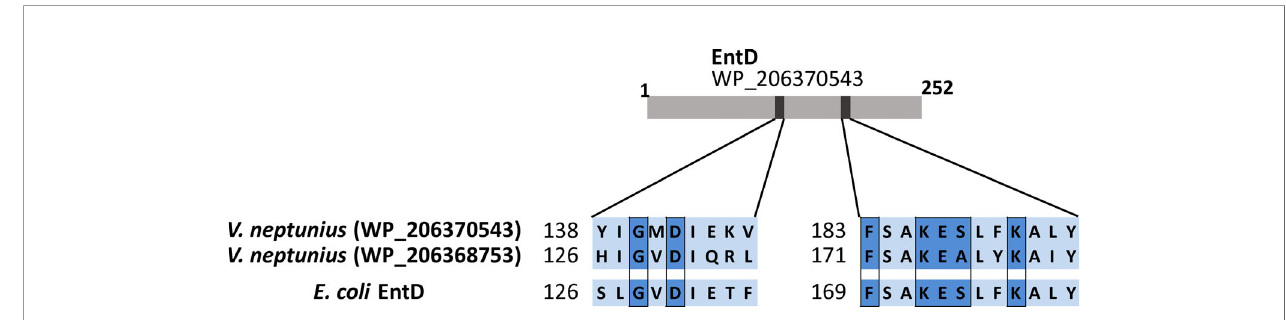
FIGURE 2 | Highly conserved residues of the type-II PPTases shared between the two V. neptunius predicted proteins and the EntD of E. coli